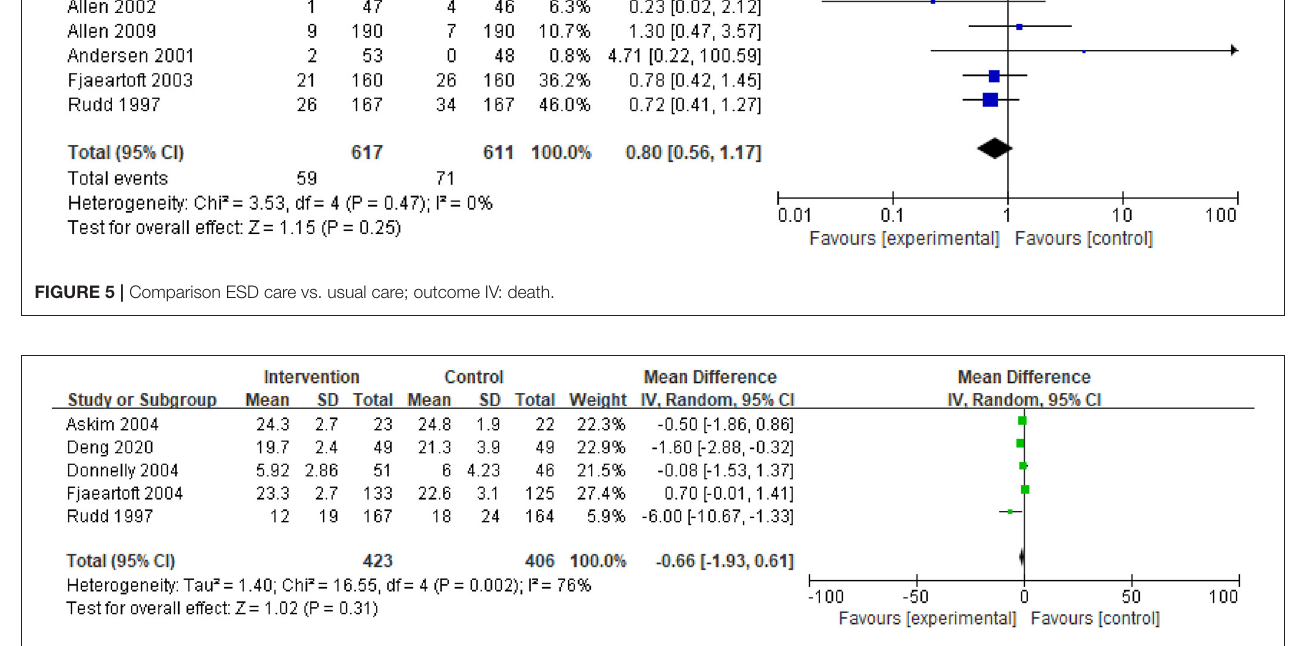
FIGURE 6 | Comparison ESD care vs. usual care; outcome 5: Caregiver Strain Index (CSI).